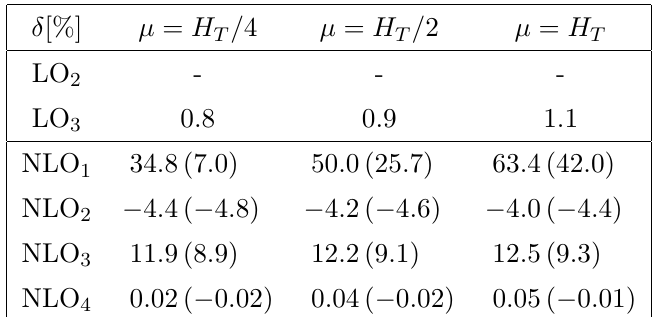
Table 3 . (cid:27) =(cid:27) LO ratios for t (cid:22) tW (cid:6) production at 13 TeV for various values of (cid:22) = (cid:22) r = (cid:22) f . (N)LO i QCD